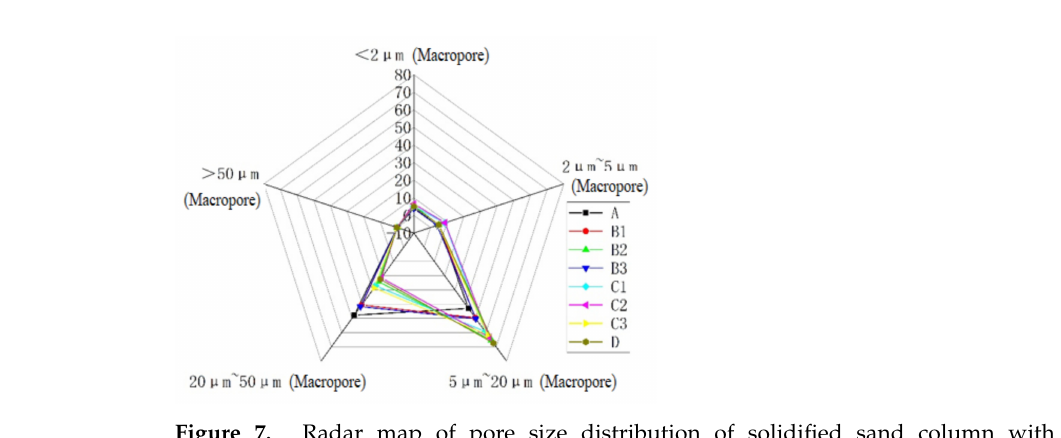
Figure 7. Radar map of pore size distribution of solidified sand column with different nutrient solutions. Statistical analysis of microstructure pore size distribution of sand solidified with different nutrient solution